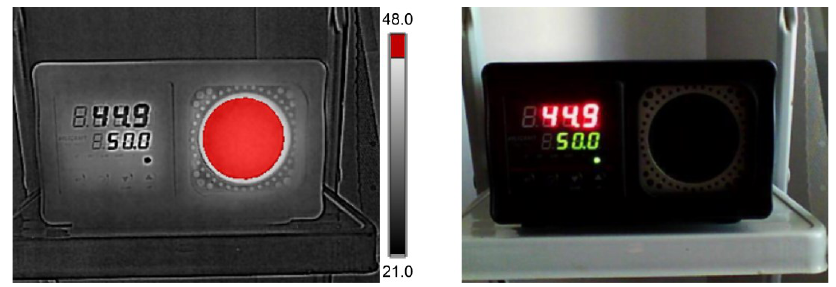
Figure 21. Voltcraft IRS-350 in operation.